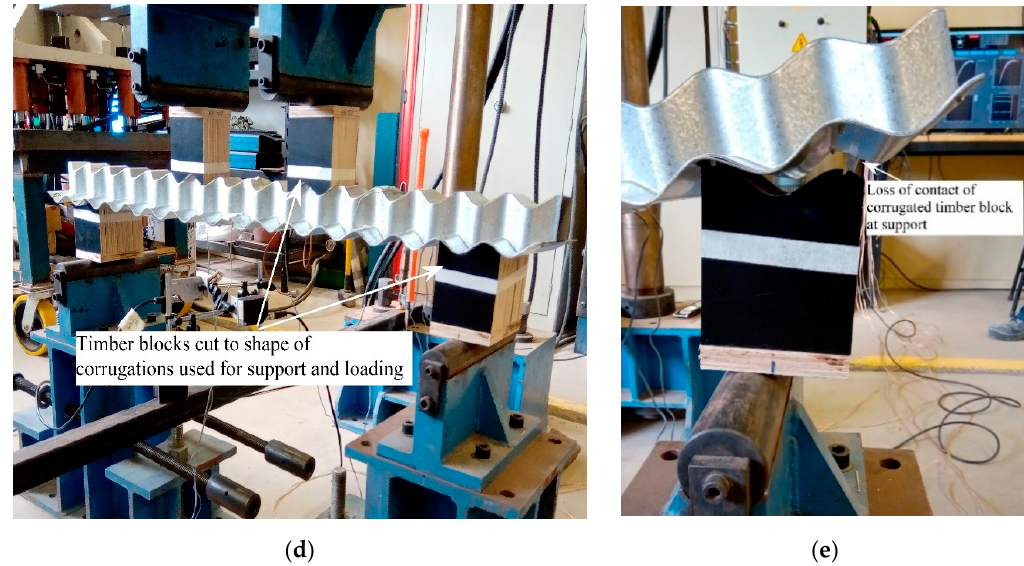
Figure 7. Details of the experimental bending test of the hat sections: ( a ) schematic showing a four-point bending test arrangement used to test the hat section; ( b ) flat timber block at support; ( c ) bending test of the hat section; ( d ) corrugated timber blocks for testing B1; and ( e ) the loss of contact of timber block at support.